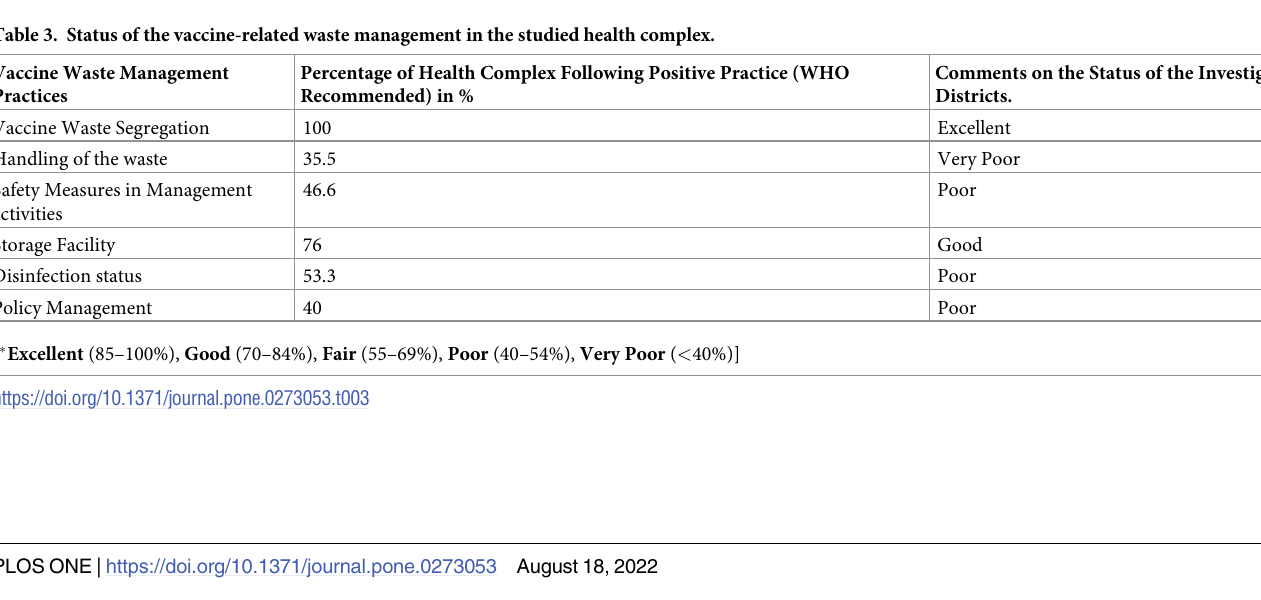
Percentage of Health Complex Following Positive Practice (WHO Recommended) in %